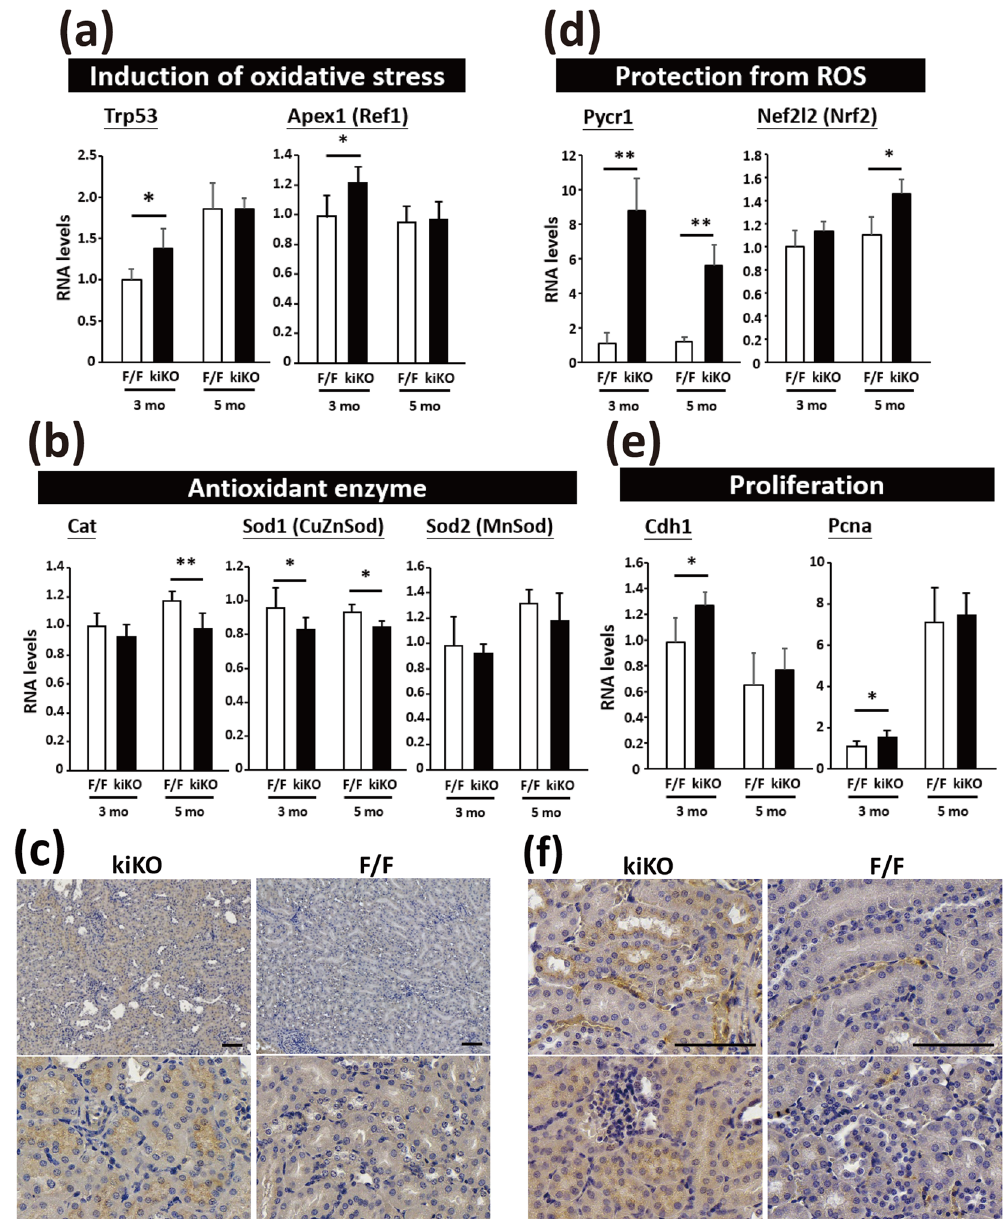
Figure 2. Elevated ROS and cell proliferation in kidney of Rrm2b kidney-specific knockout mice. ( a) The mRNA expression levels of genes related to induce oxidative stress or associated genes. Trp53 , transformation related protein 53; Apex1 ( Ref1 ), apurinic/apyrimidinic endonuclease 1. (b) The mRNA expression levels of enzymes related to antioxidant defense. Cat , catalase; Sod1 ( CuZnSod ), superoxide dismutase 1, soluble; Sod2 ( MnSod ), superoxide dismutase 2, mitochondrial. (c) IHC staining of 4-HNE, an oxidative stress marker, indicated the tissue part with oxidative damage. (d) The mRNA expression levels of Pycr1 , pyrroline-5- carboxylate reductase 1 and Nef2l2 ( Nrf2 ), nuclear factor, erythroid derived 2, like 2. (e) The mRNA expression levels of genes related to cell proliferation. Cdh1 , cadherin 1; Pcna , proliferating cell nuclear antigen. (f) IHC staining of ki67 in Rrm2b kiKO and control mice at 3 months old. Scale bar, 100 μ m. The results are presented as the mean ± SD. * p < 0.05; ** p <